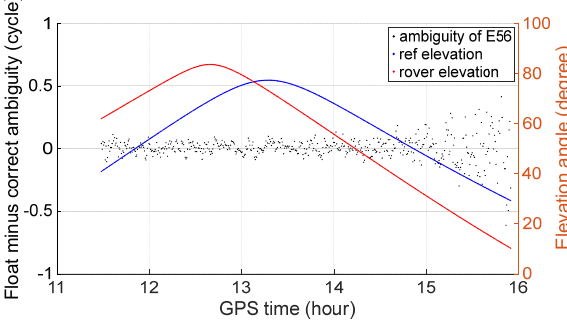
Figure 3. Ambiguity resolution of extra ‐ wide lane E56.